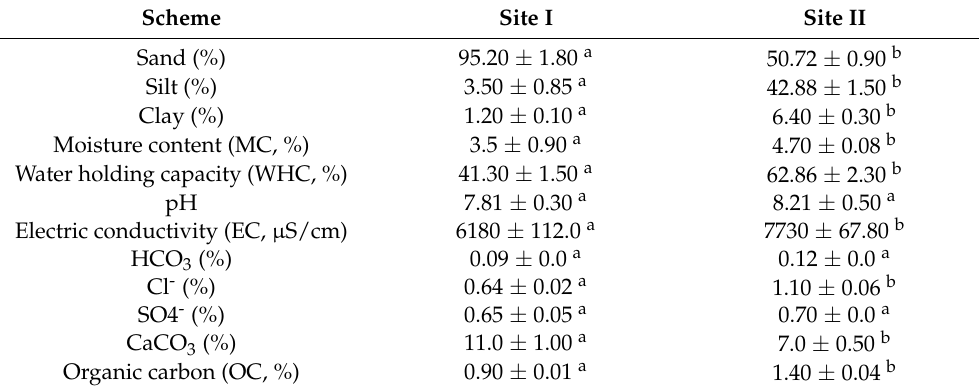
Table 1. Soil properties (mean values ± standard error) supporting the growth of A. monosperma (Site I) and L. crithmoides (Site II). Different letters in the same row are significantly different at p < 0.05. Scheme